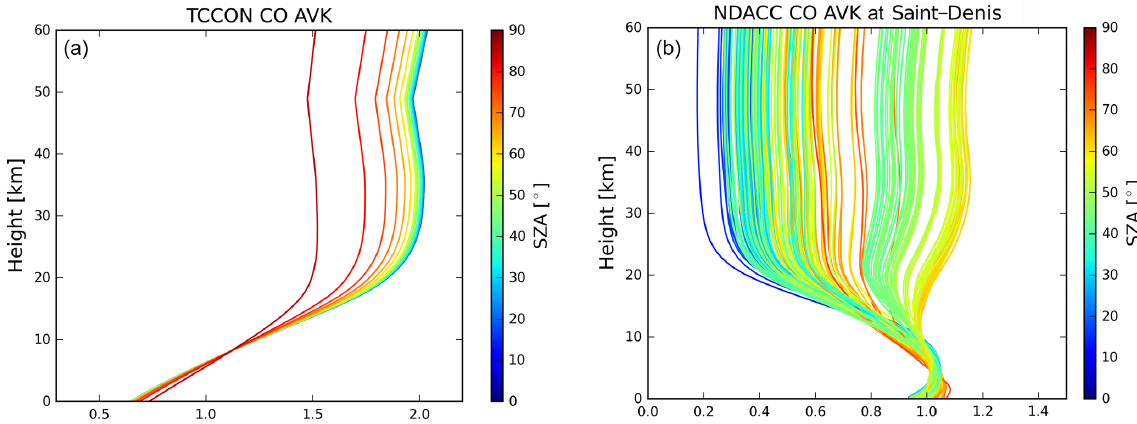
Figure 4. The column averaging kernels of TCCON (a) and NDACC (b) CO retrievals at Saint-Denis.